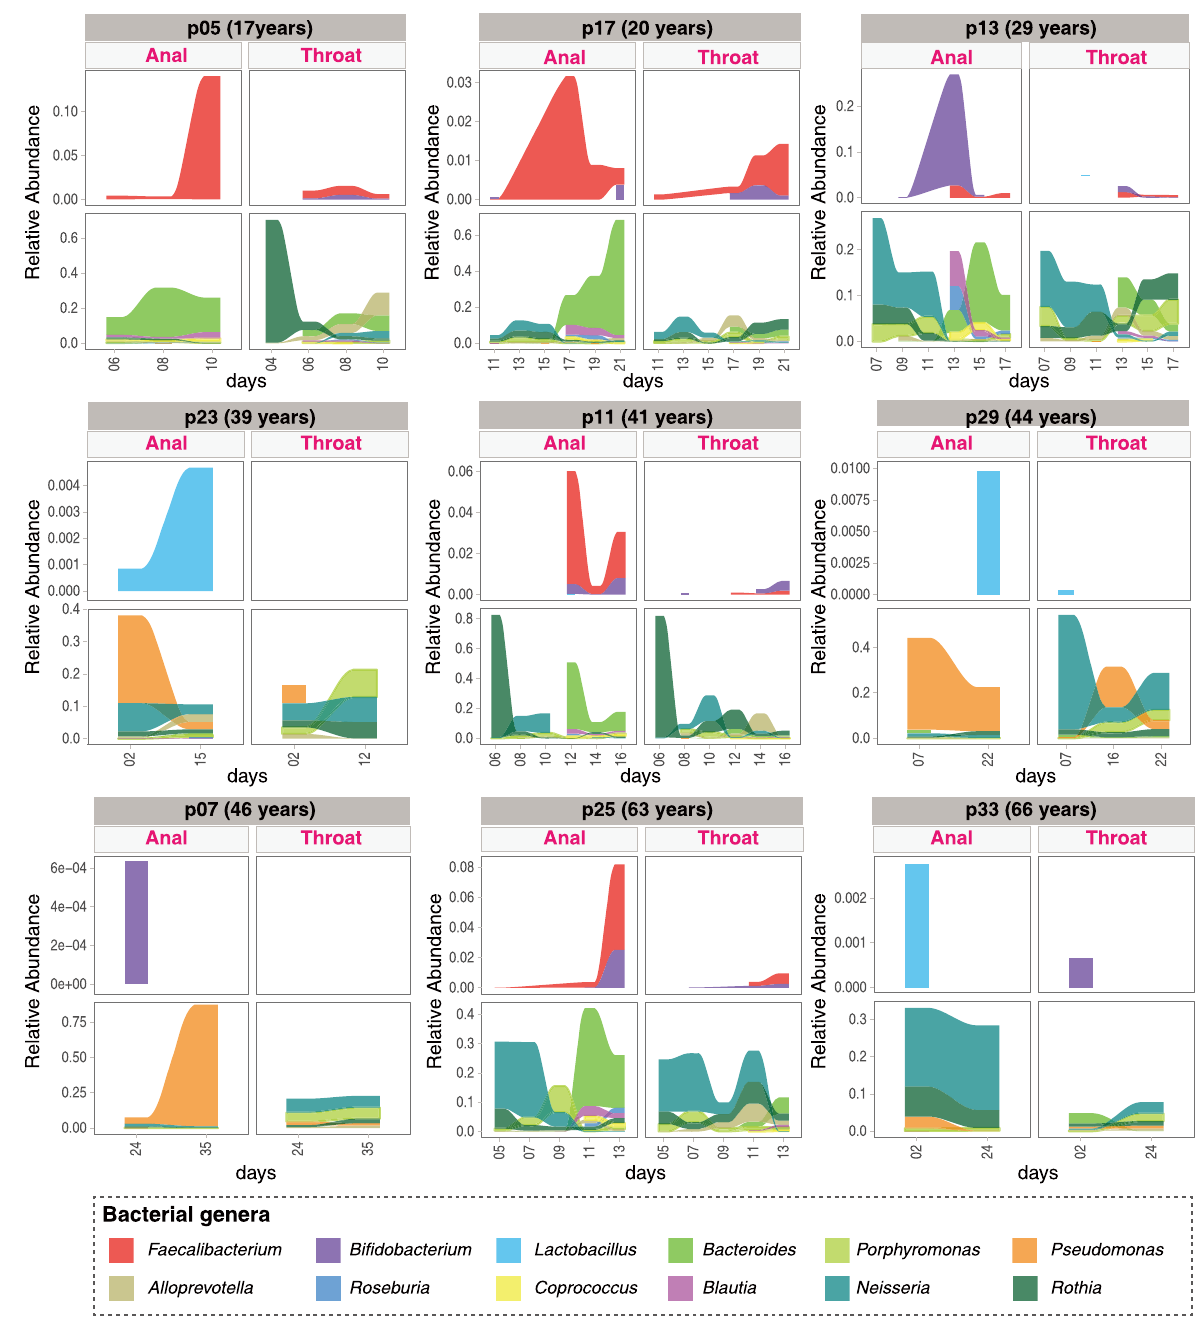
Fig. 4 Dynamic change of 12 key taxa in respiratory tract and gut of patients with mild COVID-19. Key taxa of DMM clusters and several core functional gut bacteria were shown in nine mild COVID-19 adults with at least two timepoints of sampling. Linked to Fig. 1a, Fig.2a, and Supplementary Figs. S4 and